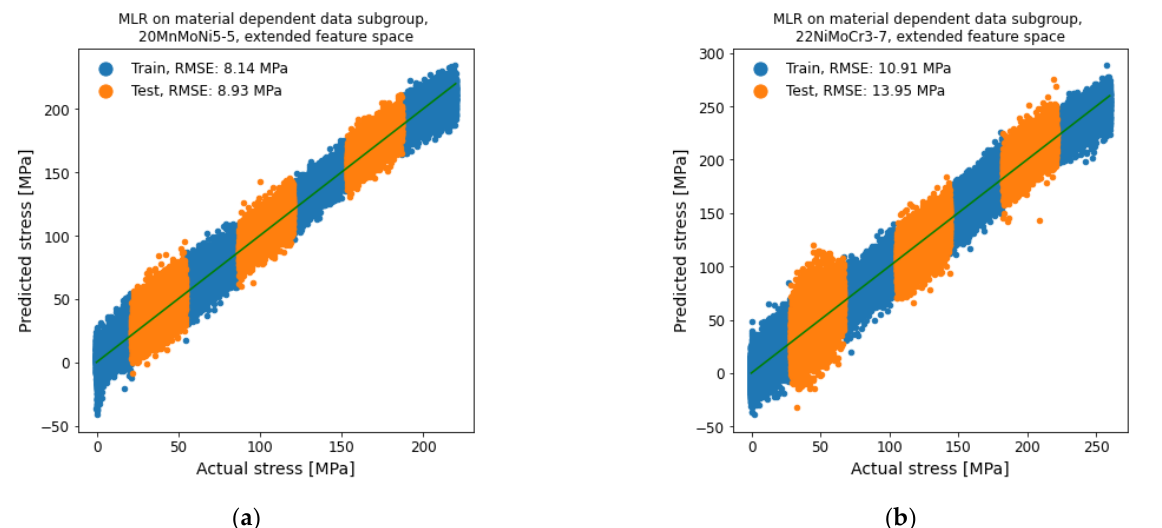
Figure 15. MLR for stress determination on material-dependent data subgroup with extended feature space. ( a ) 20MnMoNi5-5 and ( b ) 22NiMoCr3-7.